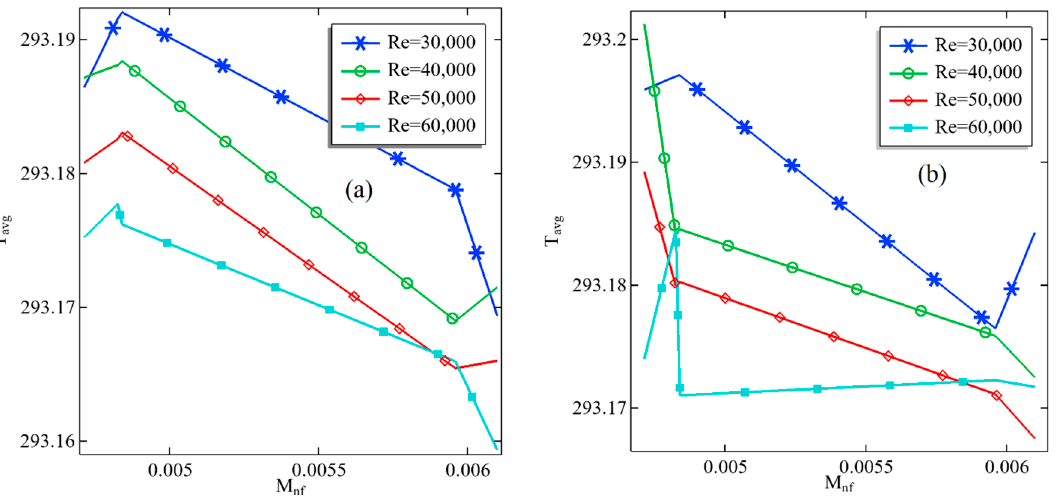
Figure 8. Decreasing average temperature of the nanofluid against the mass of the nanofluid at the outer cylinder: ( a ) ω = 0.5; ( b ) ω =